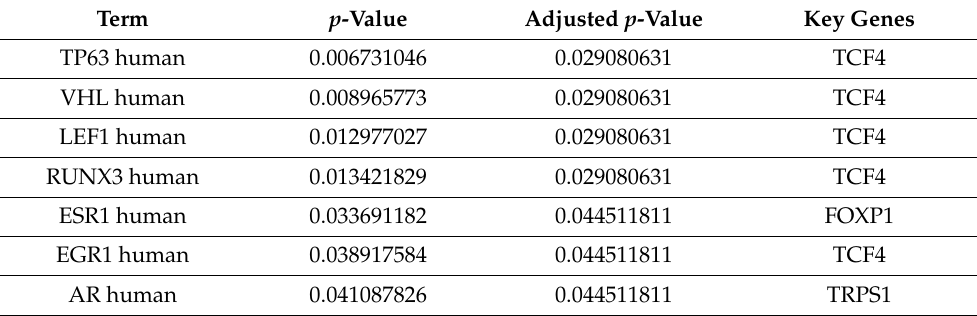
Table 3. Transcription factors prediction through